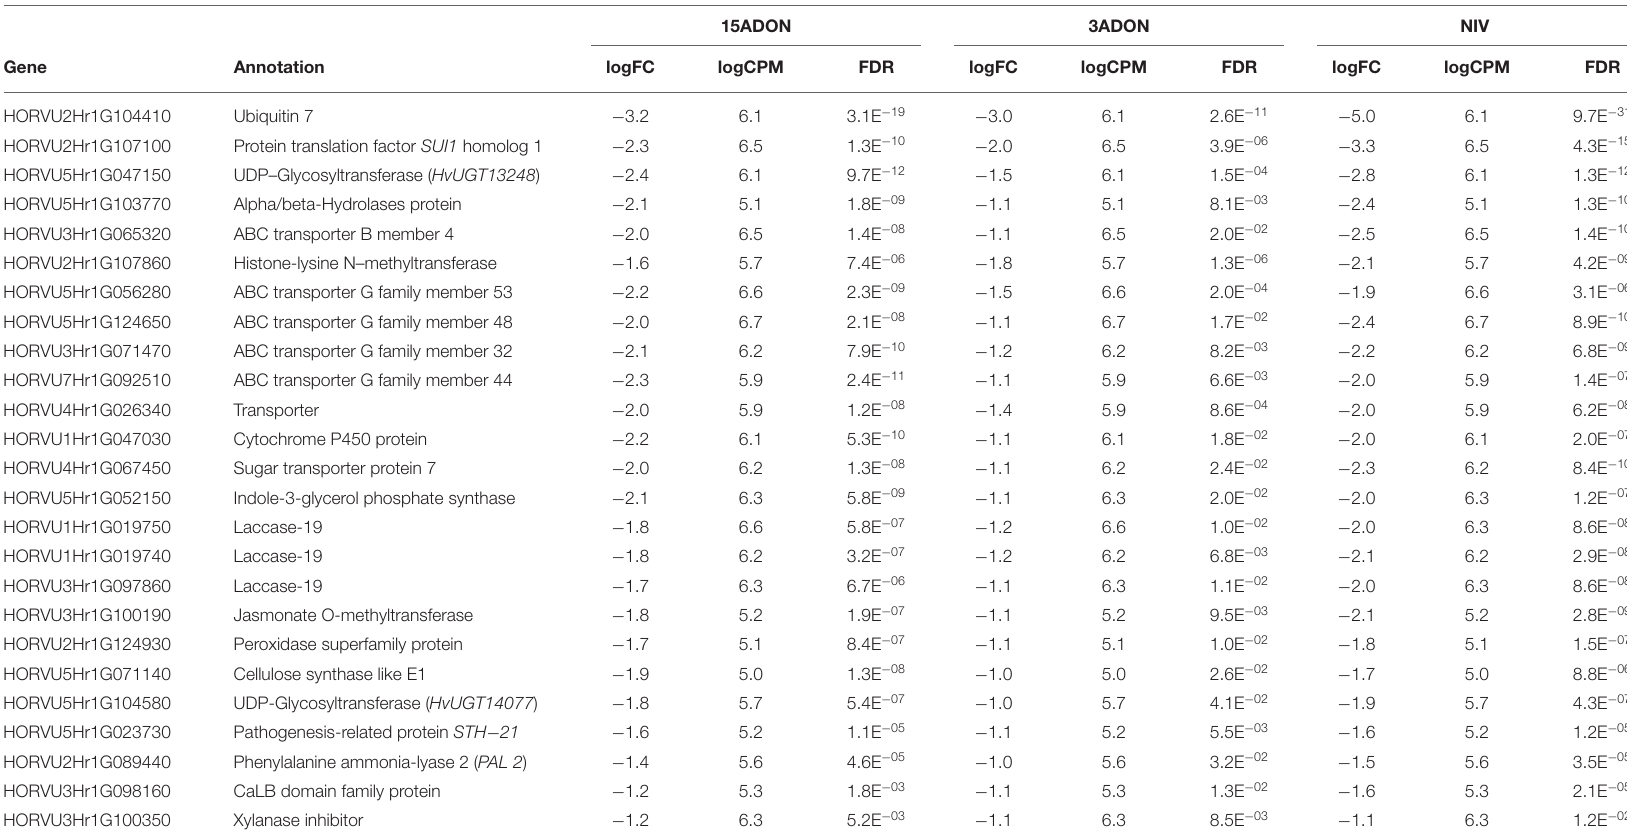
TABLE 3 | Transcript alterations in select upregulated genes expressed within Fusarium graminearum chemotype:15ADON, 3ADON, and NIV treatments contrasted with mock control identified in the additive, interactive generalized linear